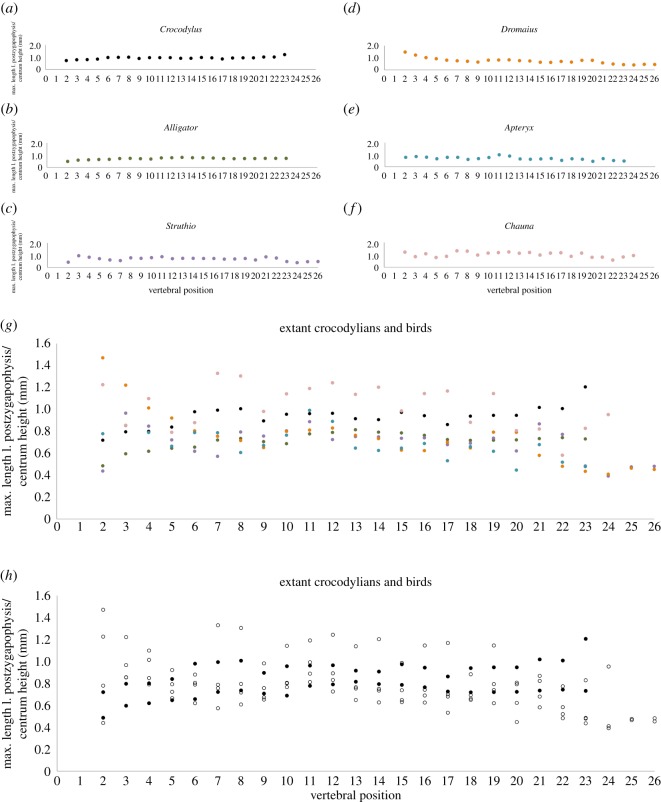
Plots showing the maximum length of postzygapophyseal articulation (proxy for surface area articulating between consecutive vertebrae) corrected for body size along the length of the presacral vertebral columns of extant crocodylians, (a) Alligator mississippiensis and (b) Crocodylus acutus, and extant birds, (c) Struthio camelus, (d) Dromaius novaehollandiae, (e) Apteryx australis, and (f) Chauna chavaria. All those data points are plotted together in (g), with the colours matching those in the above data plots. In (h) the crocodylian taxa are illustrated with filled-in data points while the bird taxa data points are outlines.